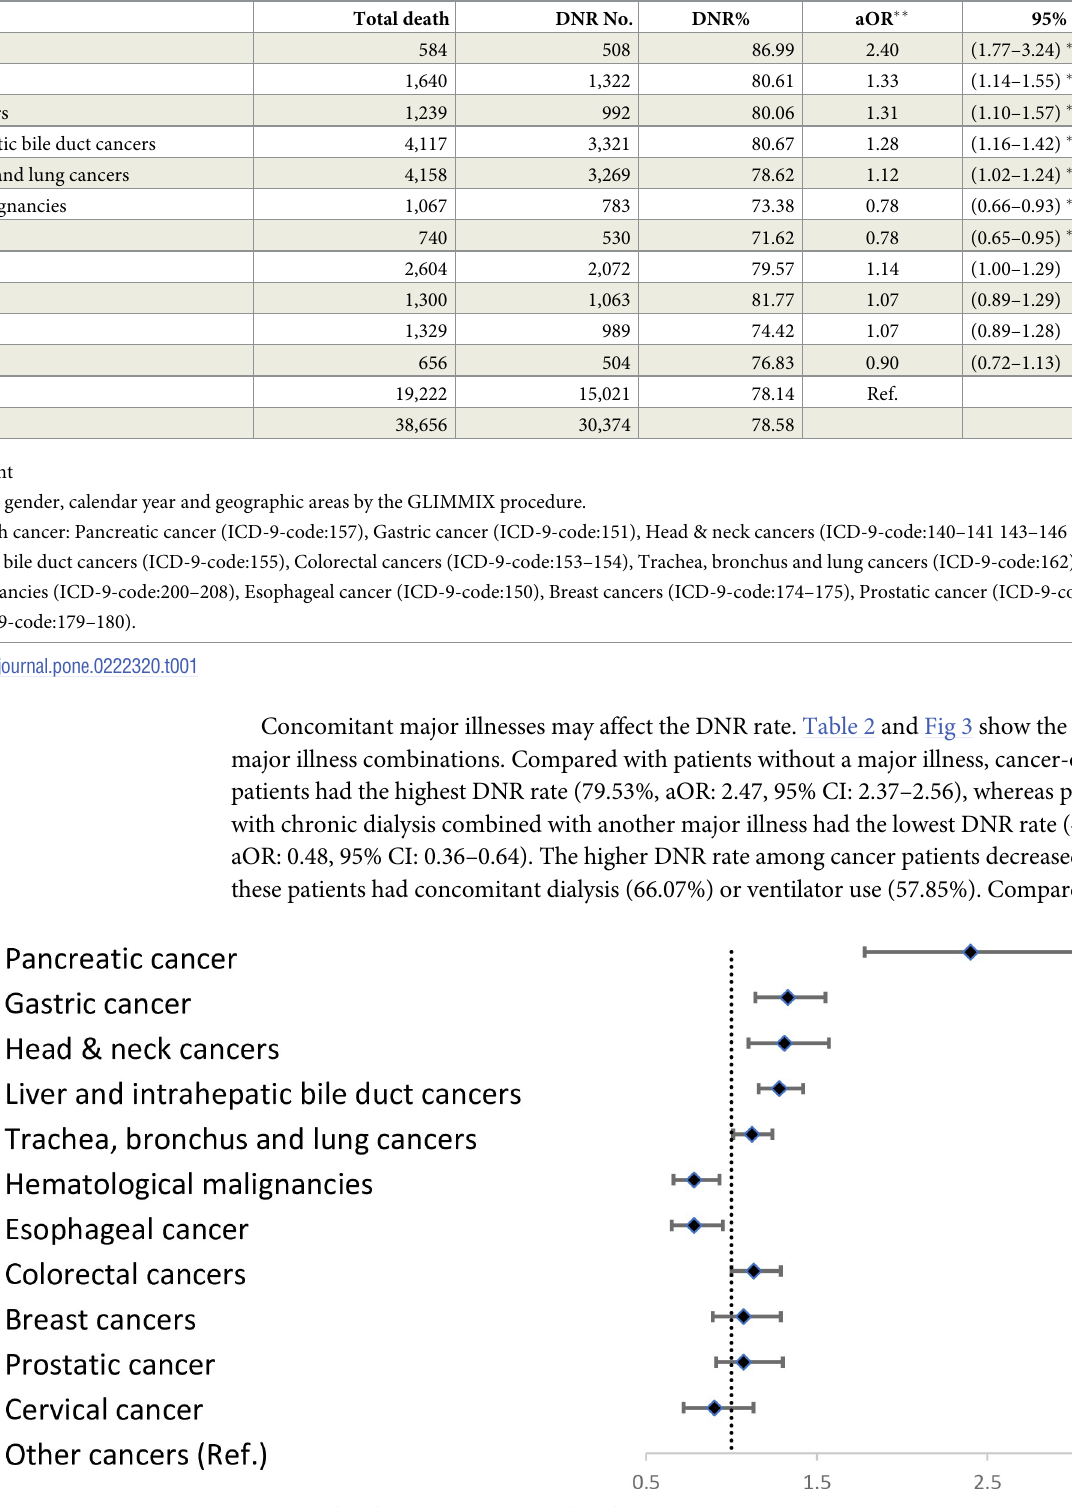
Fig 2. Forest plot: Adjusted odds ratios (aOR) of do-not-resuscitate (DNR) rates by type of